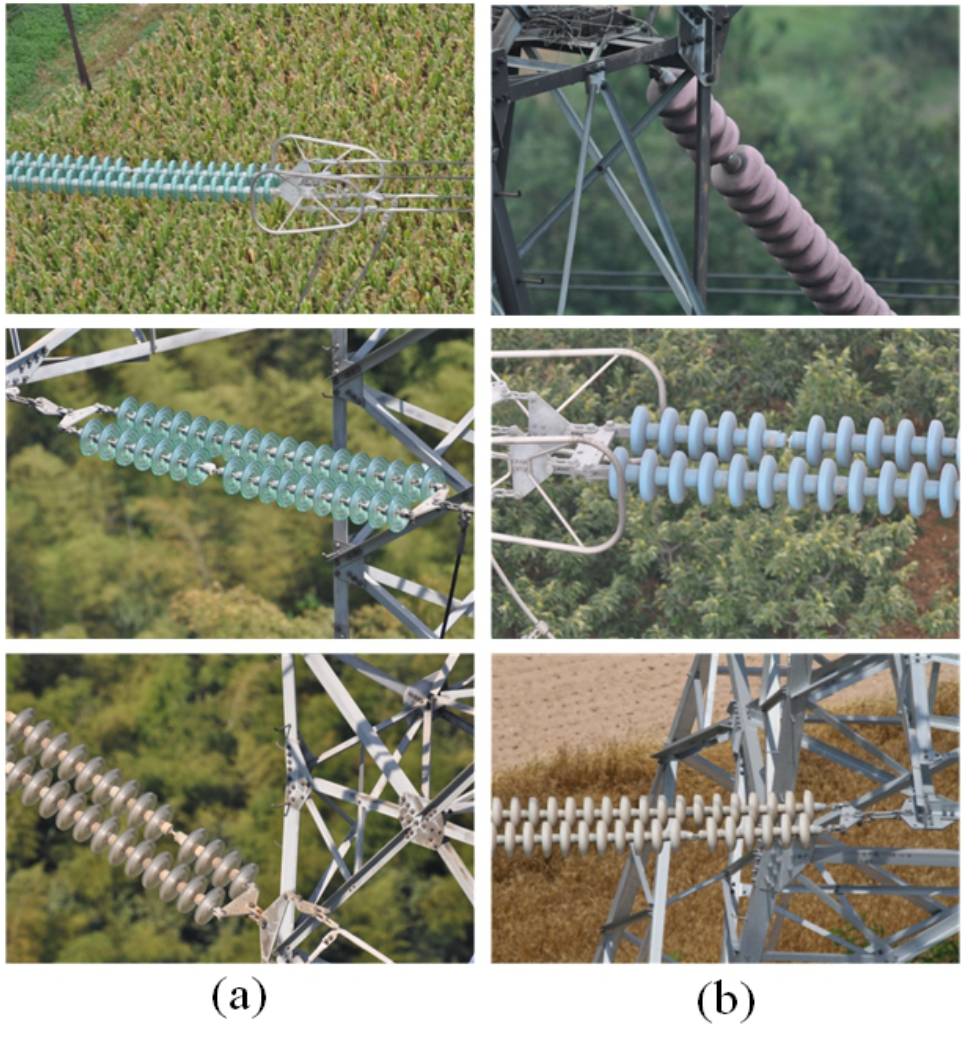
Figure 7. Glass insulators and ceramic insulators. ( a ) Glass insulators. ( b ) Ceramic